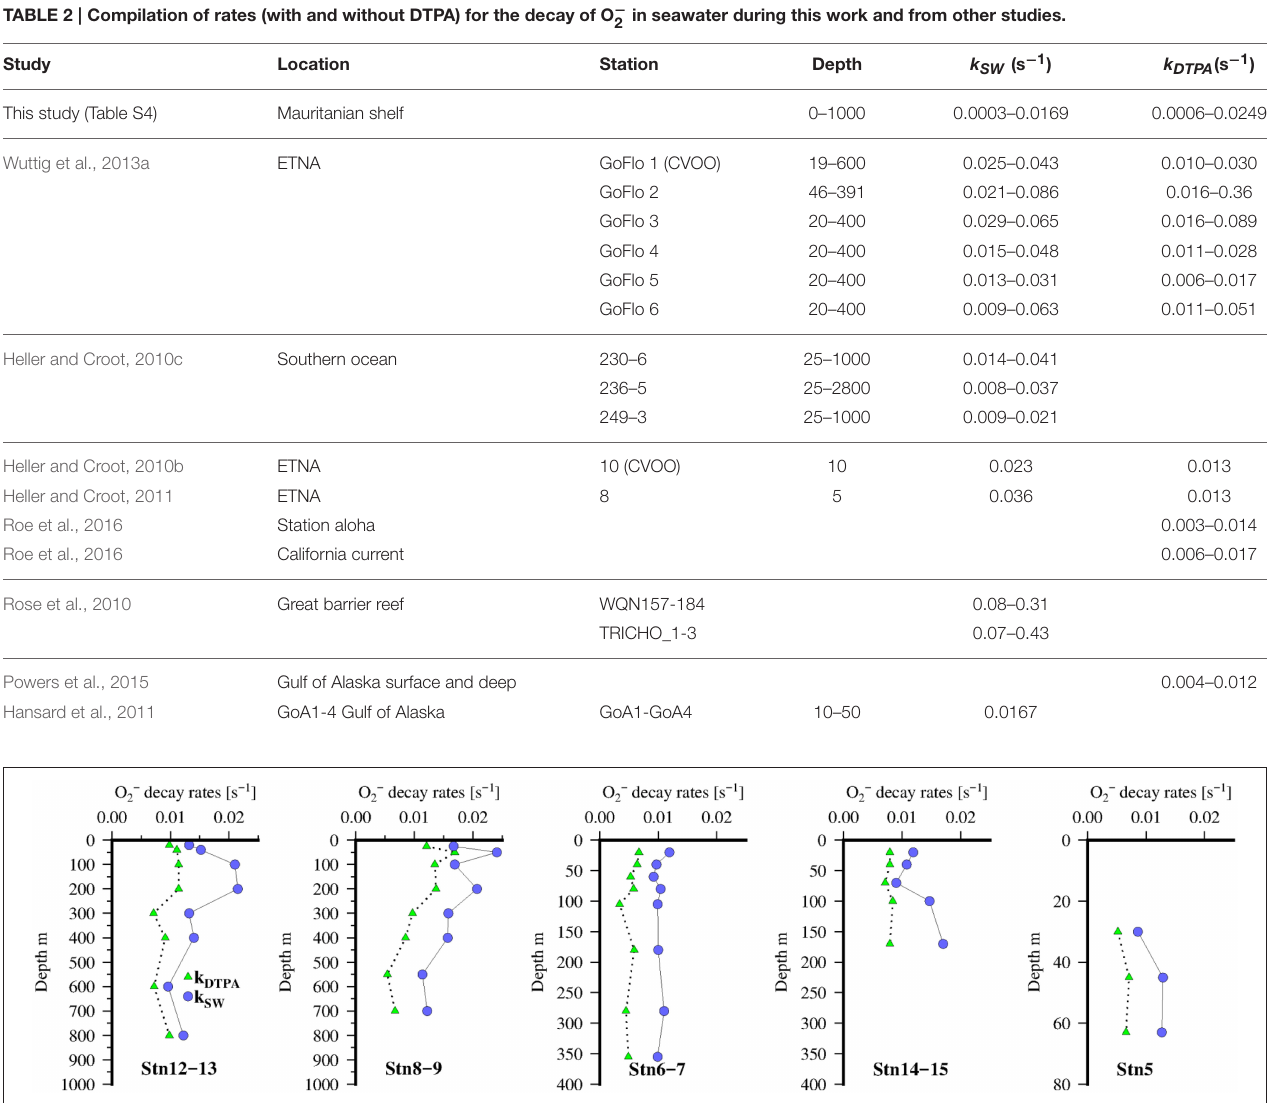
FIGURE 7 | Vertical distribution of O − 2 decomposition rates k DTPA (green triangles) and k SW (blue circles) at 5 stations along the transect in the Mauritanian